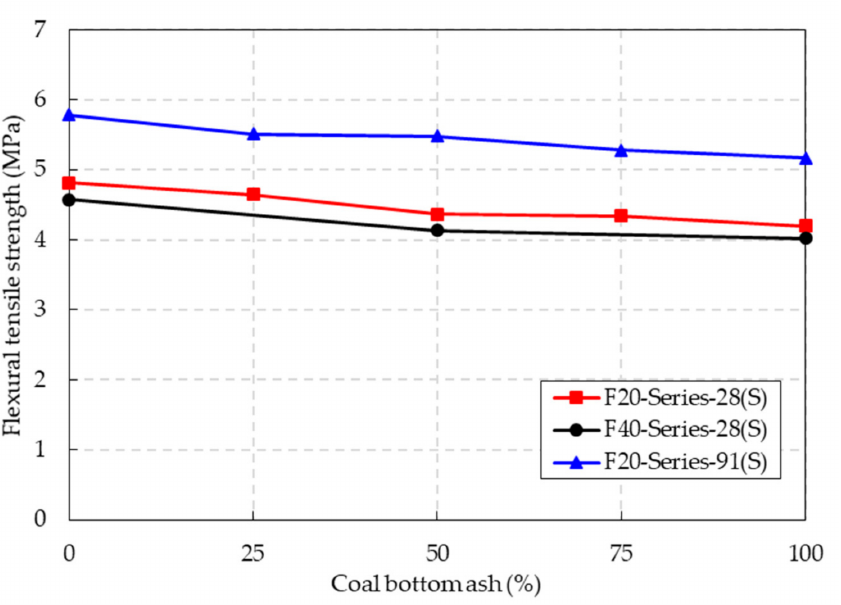
Figure 10. Flexural tensile strength of the CBA